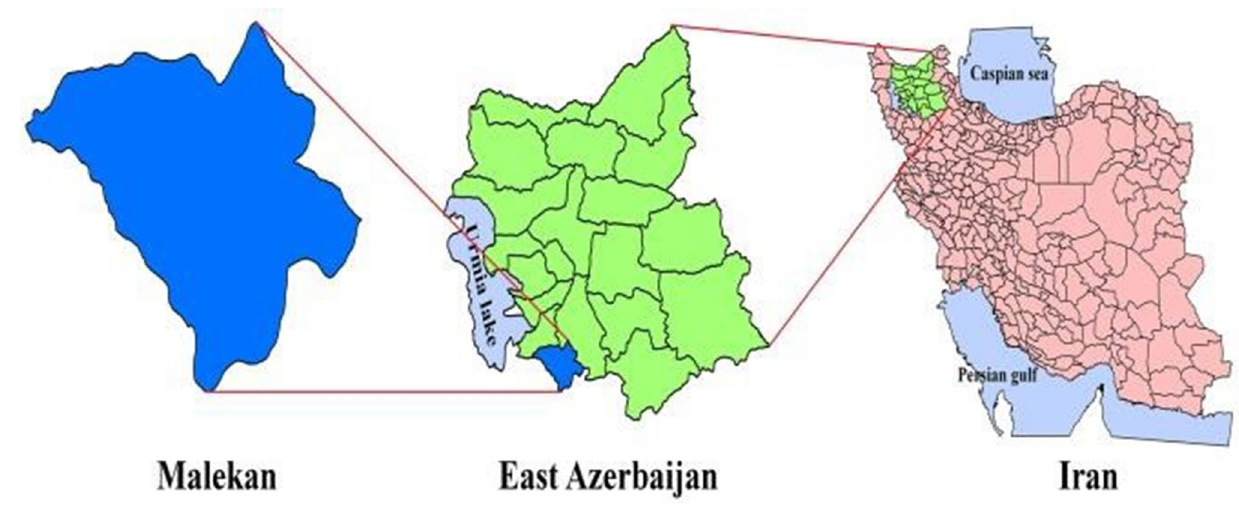
Fig. 1 Schematic of the study